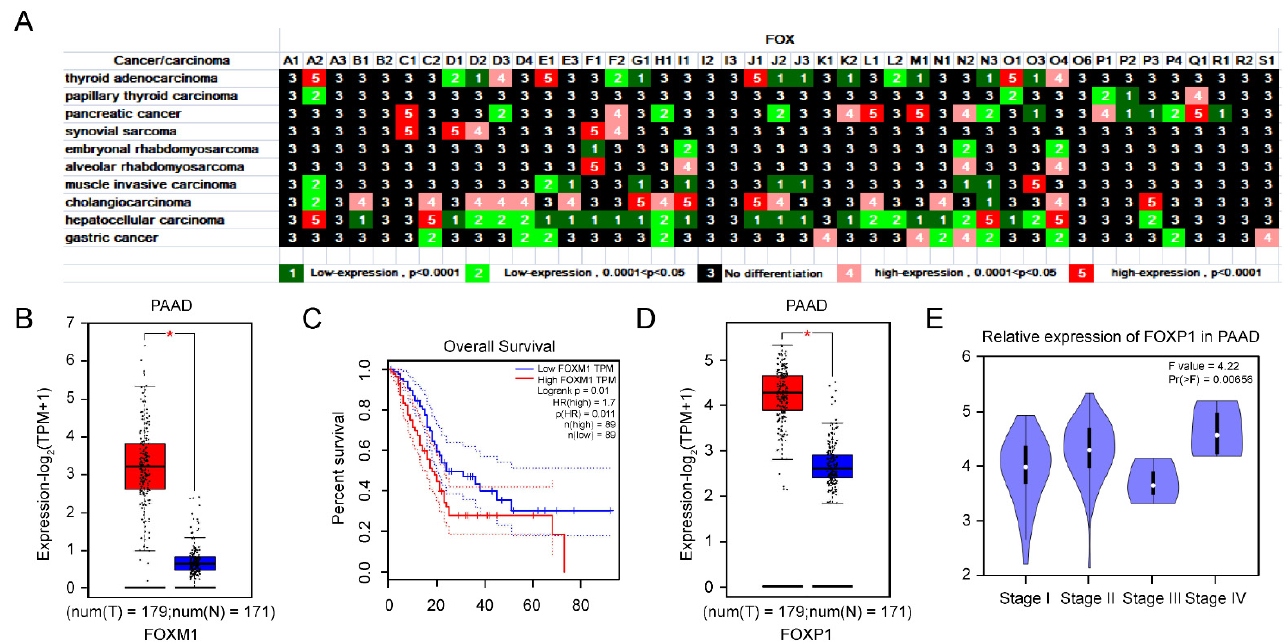
Figure 7. Differential expression of FOX genes in other cancers ( A ). ( B ) GEPIA2 data of FOXM1 expression in PAAD and normal samples. ( C ) The survival curve of PAAD patients with different FOXM1 expression level. ( D ) Difference of FOXP1 expression between PAAD and normal tissues. ( E ) Violin plots of the expression of FOXP1 with tumor stage in PAAD. p values less than 0.05 were considered to be statistically significant, * p < 0.05.